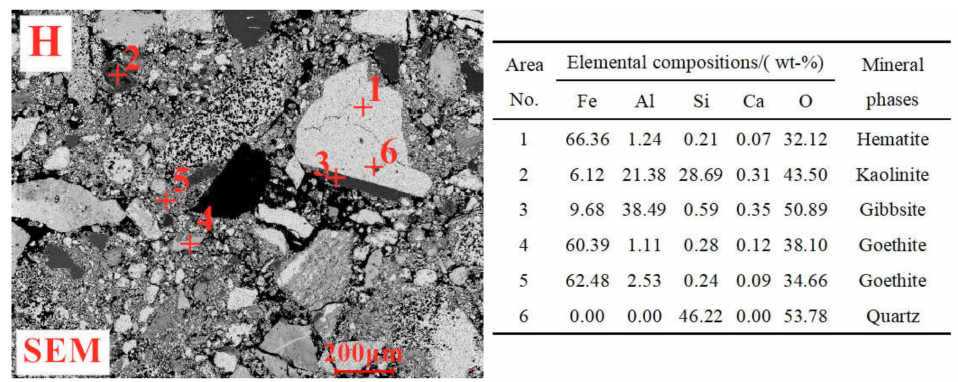
Figure A2. ( A – D ) The microstructure of Australian and Indian iron ores, ( E – H ) The microstructure of Brazilian and African iron ores.